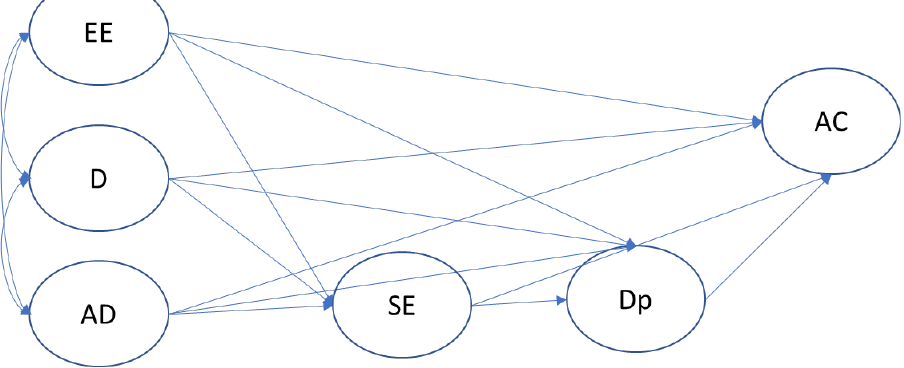
Figure 1. Mediation model of self-efficacy and depression between burnout and alcohol consumption. Latent constructs are shown in circles, and observable variables and error terms are not shown; double-headed arrows represent covariances, and single arrows represent direct effects. EE = Emo- tional Exhaustion; D = Depersonalization; AD = Achievement Dissatisfaction; SE = Self-Efficacy; Dp = Depression; AC = Alcohol Consumption.